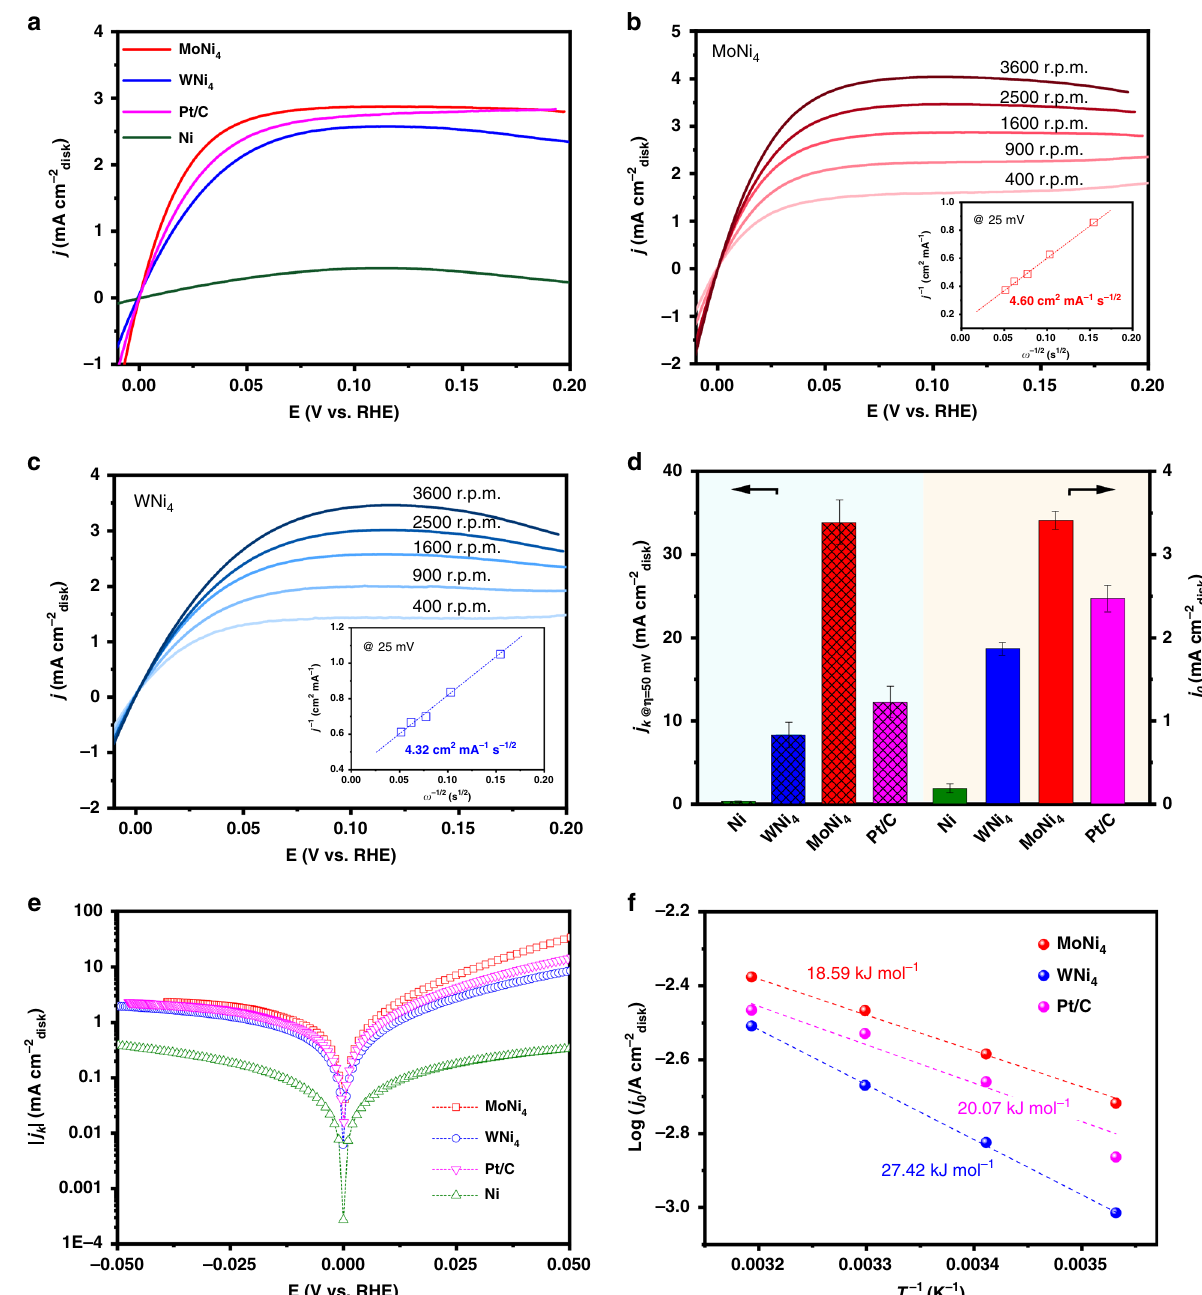
Fig. 3 Electrocatalytic HOR performances. a Polarization curves for the HOR on MoNi 4 , WNi 4 , freshly synthesized Ni, and commercial Pt/C catalyst measured in H 2 -saturated 0.1 M KOH. Sweep rate: 0.5 mV s − 1 . Rotation speed: 1600 r.p.m. b , c HOR polarization curves for MoNi 4 and WNi 4 alloys at various rotation speeds, respectively. Sweep rate: 0.5 mV s − 1 . Insets in b , c show corresponding Koutecky – Levich plots at an overpotential of 25 mV. d Comparison of kinetic current density ( j k ) at 50 mV (patterned) and apparent exchange current density ( j 0 ; unpatterned) of different studied catalysts. The error bars (standard deviations) in d are calculated based on three independent test results. e HOR/HER Tafel plots of the kinetic current density on MoNi 4 , WNi 4 , Ni, and Pt/C in H 2 -saturated 0.1 M KOH. f Arrhenius plots of the HOR/HER exchange current densities on MoNi 4 , WNi 4 , and Pt/C catalysts in 0.1 M